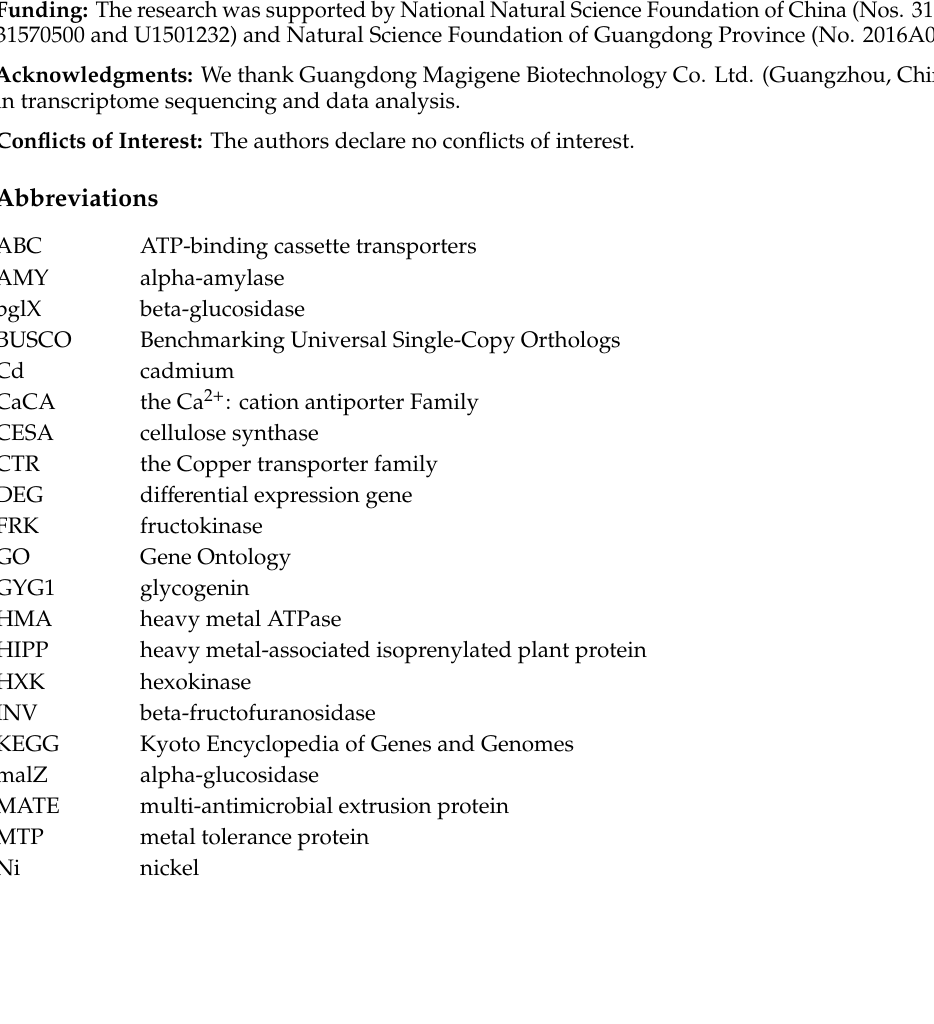
evaluation. Table S3. Statistics of upregulated DEGs in the UPS pathway. Table S4. Statistics of downregulated DEGs in the UPS pathway. Table S5. Statistics of upregulated DEGs in the sucrose metabolism pathway. Table S6. Statistics of downregulated DEGs in the sucrose metabolism pathway. Table S7. Statistics of upregulated DEGs encoding transporters. Table S8. Statistics of downregulated DEGs encoding transporters. Table S9. V. baoshanensis specific upregulated transcripts in roots in response to Cd stress. Table S10. V. baoshanensis specific upregulated transcripts in shoots in response to Cd stress. Table S11. Fold changes of DEGs involved in the UPS pathway between V. baoshanesis and V. inconspicua . Table S12. Fold changes of DEGs involved in sucrose metabolism between V. baoshanesis and V. inconspicua . Table S13. Fold changes of DEGs encoding transporters between V. baoshanesis and V. inconspicua . Table S14. Detailed proportions of GO terms in V. baoshanensis and V. inconspicua . Figure S1. Length distribution of entire transcripts and orthologous transcripts in V. baoshanensis and V. inconspicua . Figure S2. Volcano plots of gene transcription-level changes in the two Viola species with di ff erent Cd treatments (from 0 µ M to 100 µ M). Figure S3. A Venn diagram of specific and common up-regulated transcripts in V. baoshanensis and V. inconspicua in response to Cd stress. Figure S4. Summary of significantly upregulated genes in V. baoshanensis compared with V. inconspicua . Figure S5. GO enrichment of upregulated DEGs in V. baoshanensis and V. inconspicua . Figure S6. KEGG enrichment of upregulated DEGs in roots and shoots of V. baoshanensis compared with V. inconspicua . Figure S7. KEGG enrichment of up-regulated DEGs in V. baoshanensis and V. inconspicua . the experiments; H.S., C.B. and J.L. (Jieliang Liang) analyzed the data; H.S. prepared the manuscript; B.L., Q.S.,